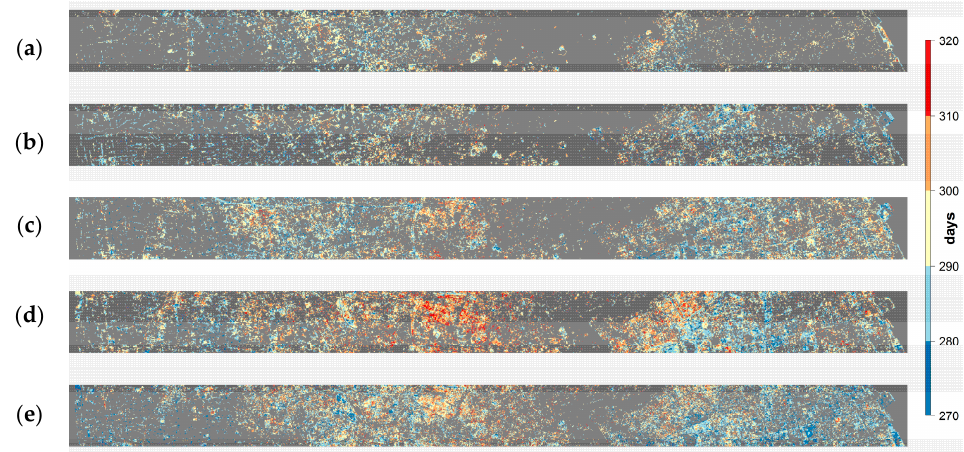
Figure 5. Spatial pattern of the mean EOS for urban vegetation along the east-west transect for the five periods: ( a ) 1984–1995; ( b ) 1996–2000; ( c ) 2001–2005; ( d ) 2006–2010 and ( e ) 2011–2015.